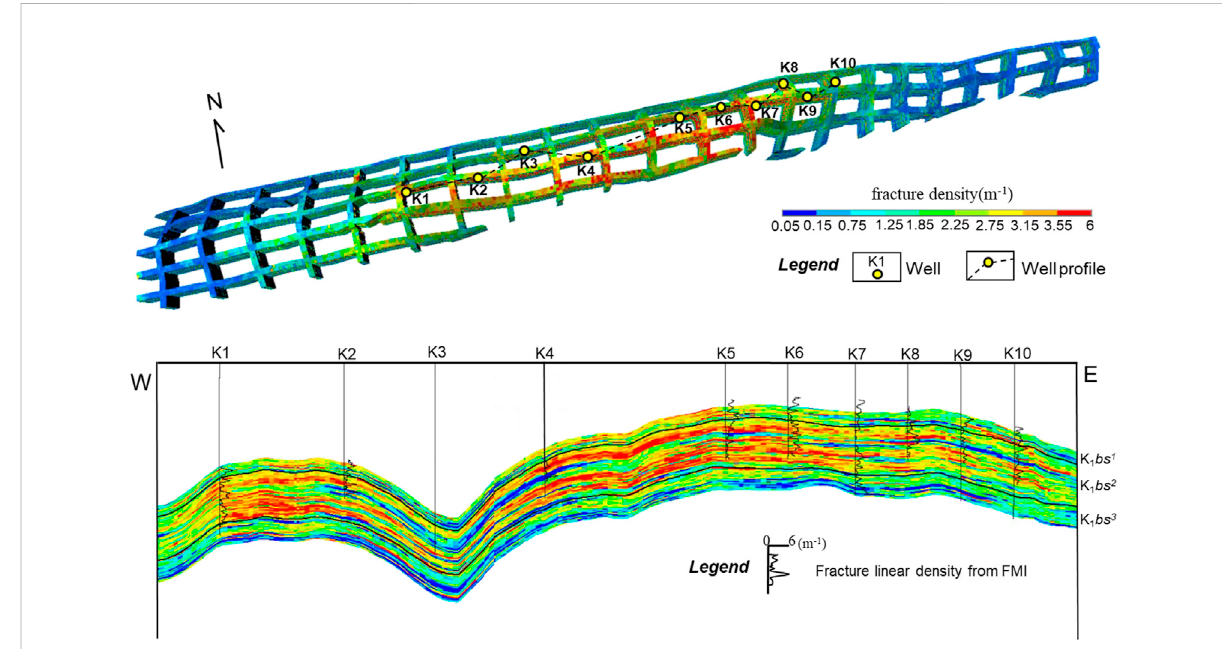
FIGURE 13 The 3D simulation results and pro fi le distribution characteristics of fracture total density in E-W